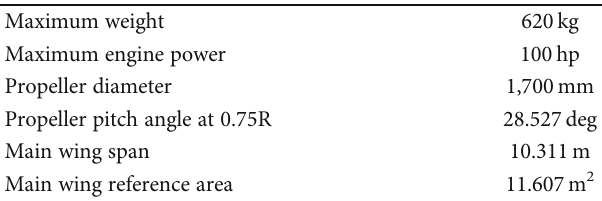
ð s Þ , G ð s Þ , and G ð s Þ are the PID controller. 6 DOF der. G 1 2 3 (degree of freedom) is the fl ight dynamics model. Figure 9 indicates the shape of a KLA-100 sports light aircraft. The con fi guration data of the KLA-100 has been de fi ned in